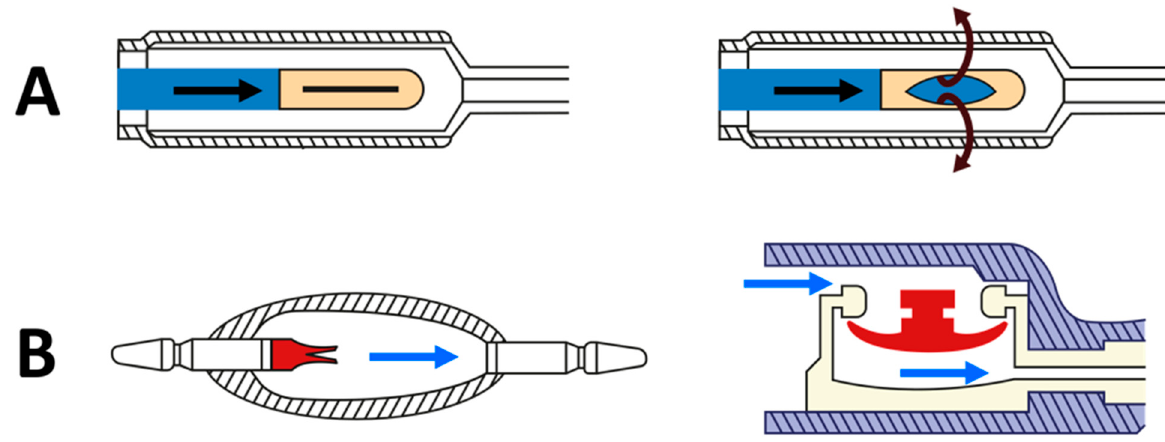
Figure 5. ( A ). Schematic drawing of a silicone slit valve. Slit valves are essentially silicon tubes that are closed at the end and have slits in their sides. On the left, a closed tube with a lateral slit is shown. On the right, the slit opens and allows CSF flow when the pressure inside the tube exceeds the predefined OP setting defined by the manufacturer. Arrows indicate the direction of CSF flow. ( B ). On the left, an opener miter valve is shown. The two silicon leaflets open when CSF inside the shunt exceeds the predefined OP. ( B ). On the right, a drawing of a diaphragm valve is shown. When CSF in the circuit exceeds the OP of the valve, the diaphragm moves down and allows the fluid to pass through. Arrows indicate the direction of the flow.